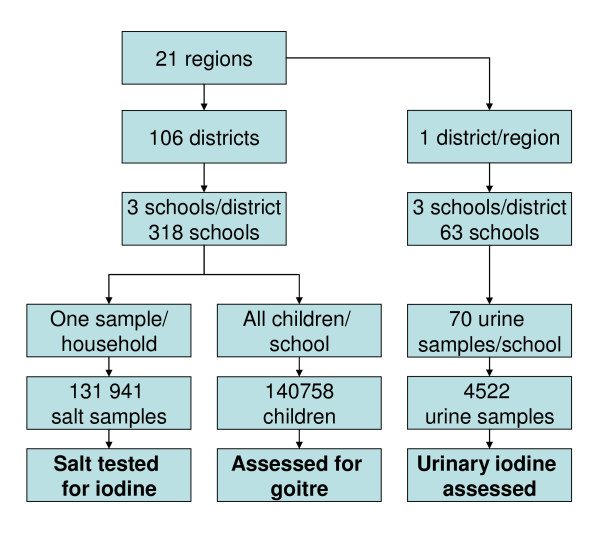
Summary of the survey sampling procedure.